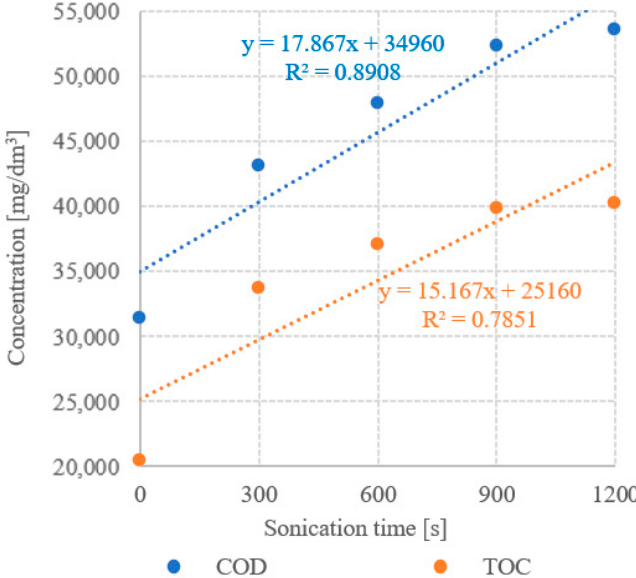
Figure 13. Correlation between UD time and concentration of dissolved organic compounds.